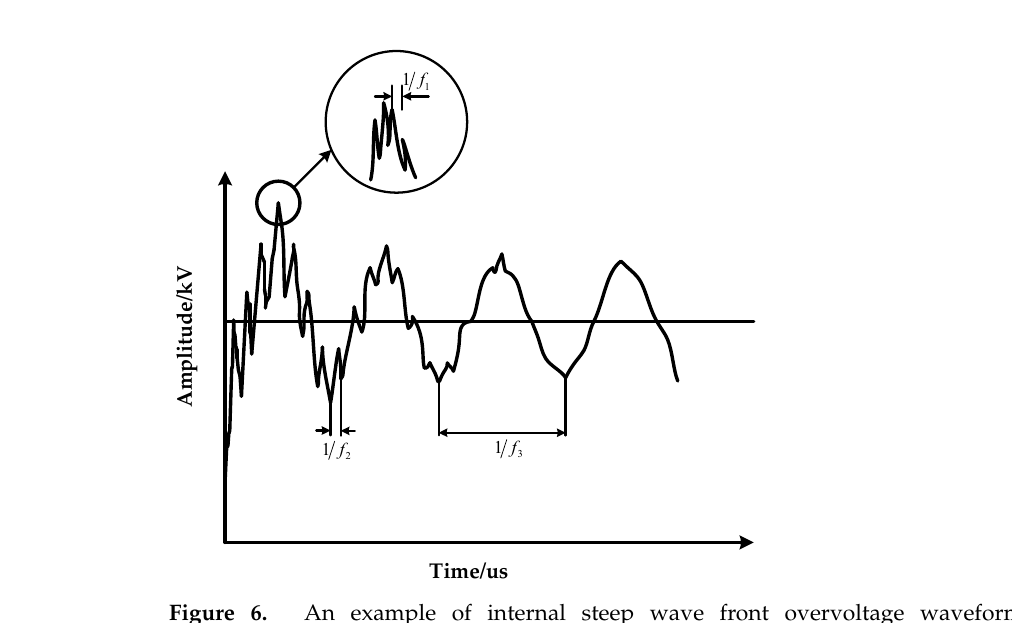
Figure 6. An example of internal steep wave front overvoltage waveform caused by disconnector closing.